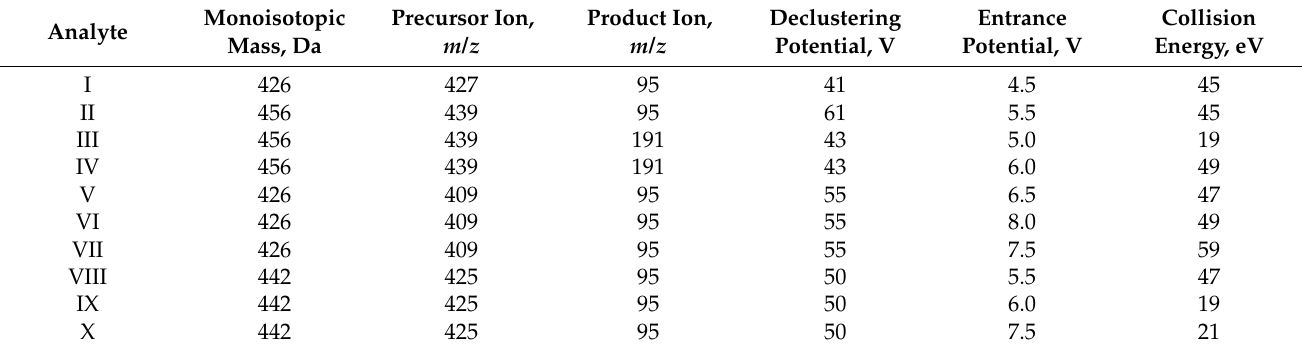
Table 1. Optimized conditions of PCT mass spectrometric detection in MRM mode.